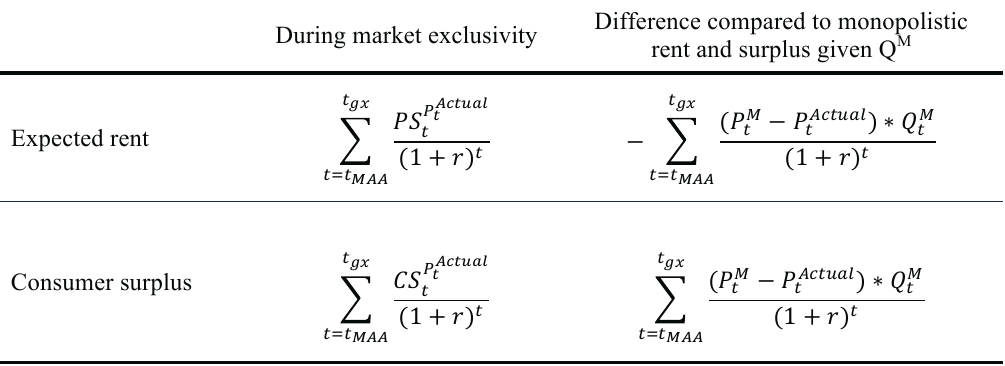
Table A2: Expected rent and consumer surplus during the time of patent protection given the use of IRP or PT and unchanged utilisation (Q M ). Difference compared to monopolistic During market exclusivity rent and surplus given Q M